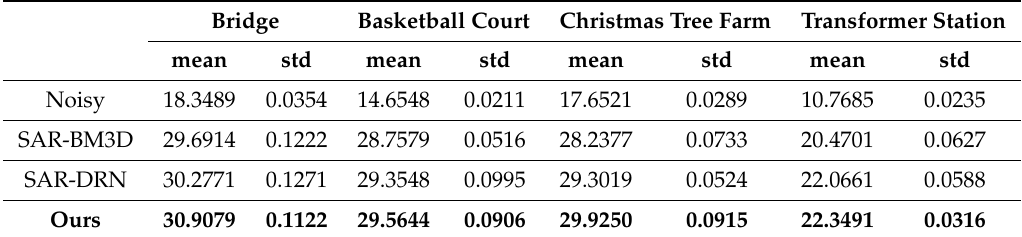
Table 1. PSNR computed on test